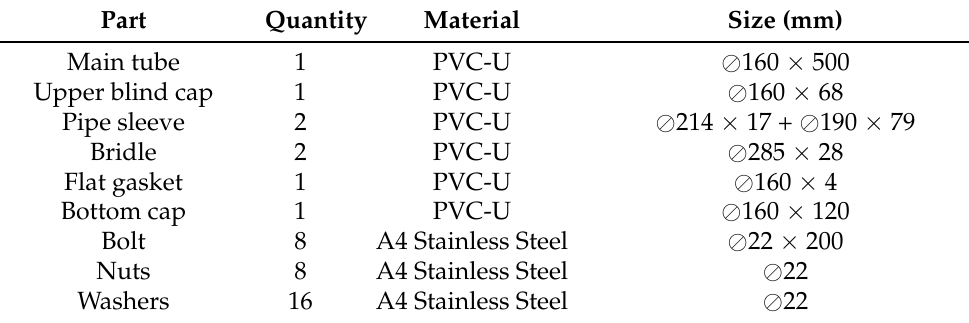
is the diameter). (cid:11)